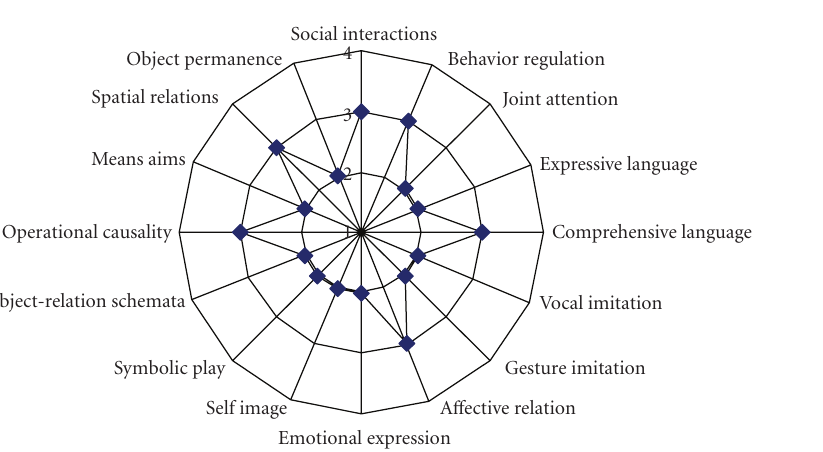
Figure 1: Illustration of the developmental profile of an 8-year old autistic child.